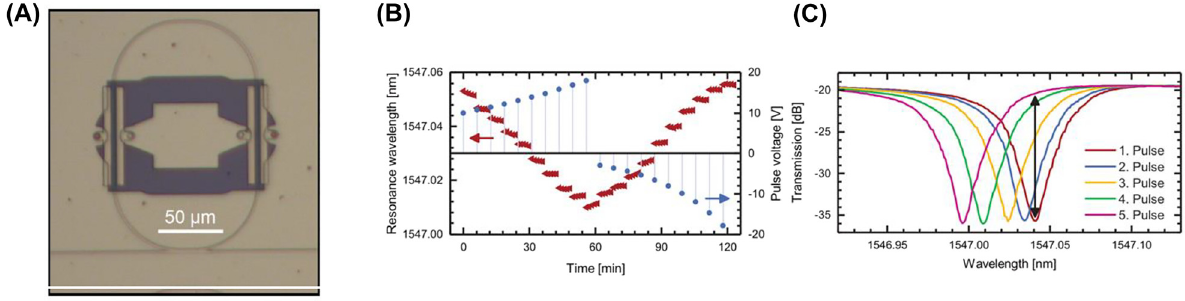
Figure 10: Ferroelectric barium titanate phase shifter in integrated photonic circuits. (A) BTO incorporated into a racetrack resonator [117]. (B) Voltage pulses between − 10 V and + 20 V are applied to set the device to 10 distinguishable resonant wavelengths. (C) Transmission spectrum after fi ve voltage pulses are applied with the transmission contrast